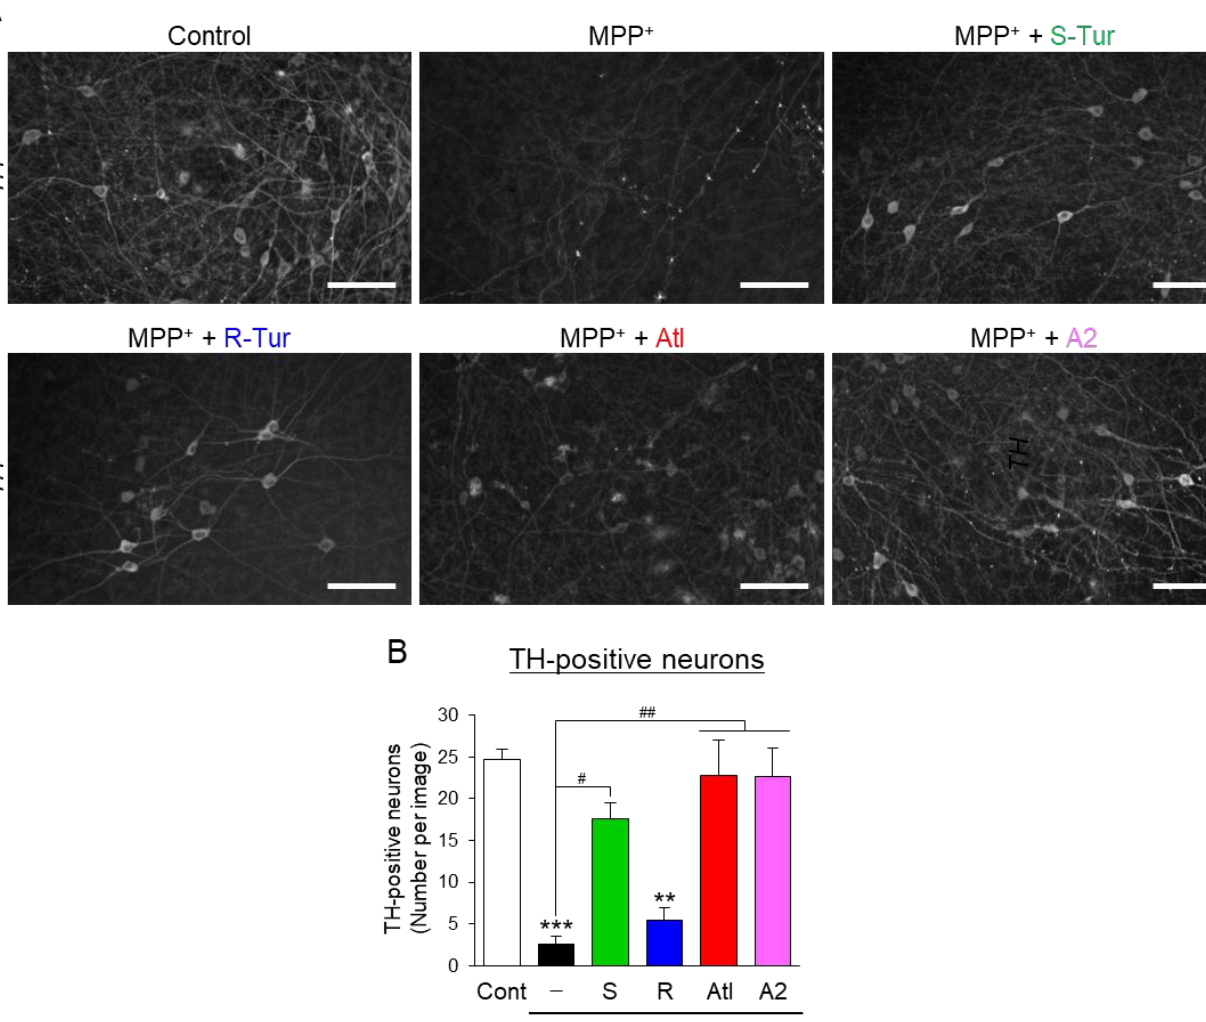
(upper panels) or presence (lower panels) of 2 µ M PLX5622, which reduces microglia, for 13 days (DIV7-20). Slices were cultured under the control condition (left), treated with IFN γ /LPS (center), or treated with 10 µ M MPP + (right). Scale bars, 100 µ m. ( C ) Quantitative analyses of TH-positive neurons in midbrain slice cultures. Data are presented as the mean ± SEM of three independent samples. * p < 0.05, ** p < 0.01 vs. control, # p < 0.05 (n = 3, one-way ANOVA, followed by a post hoc Tukey test).